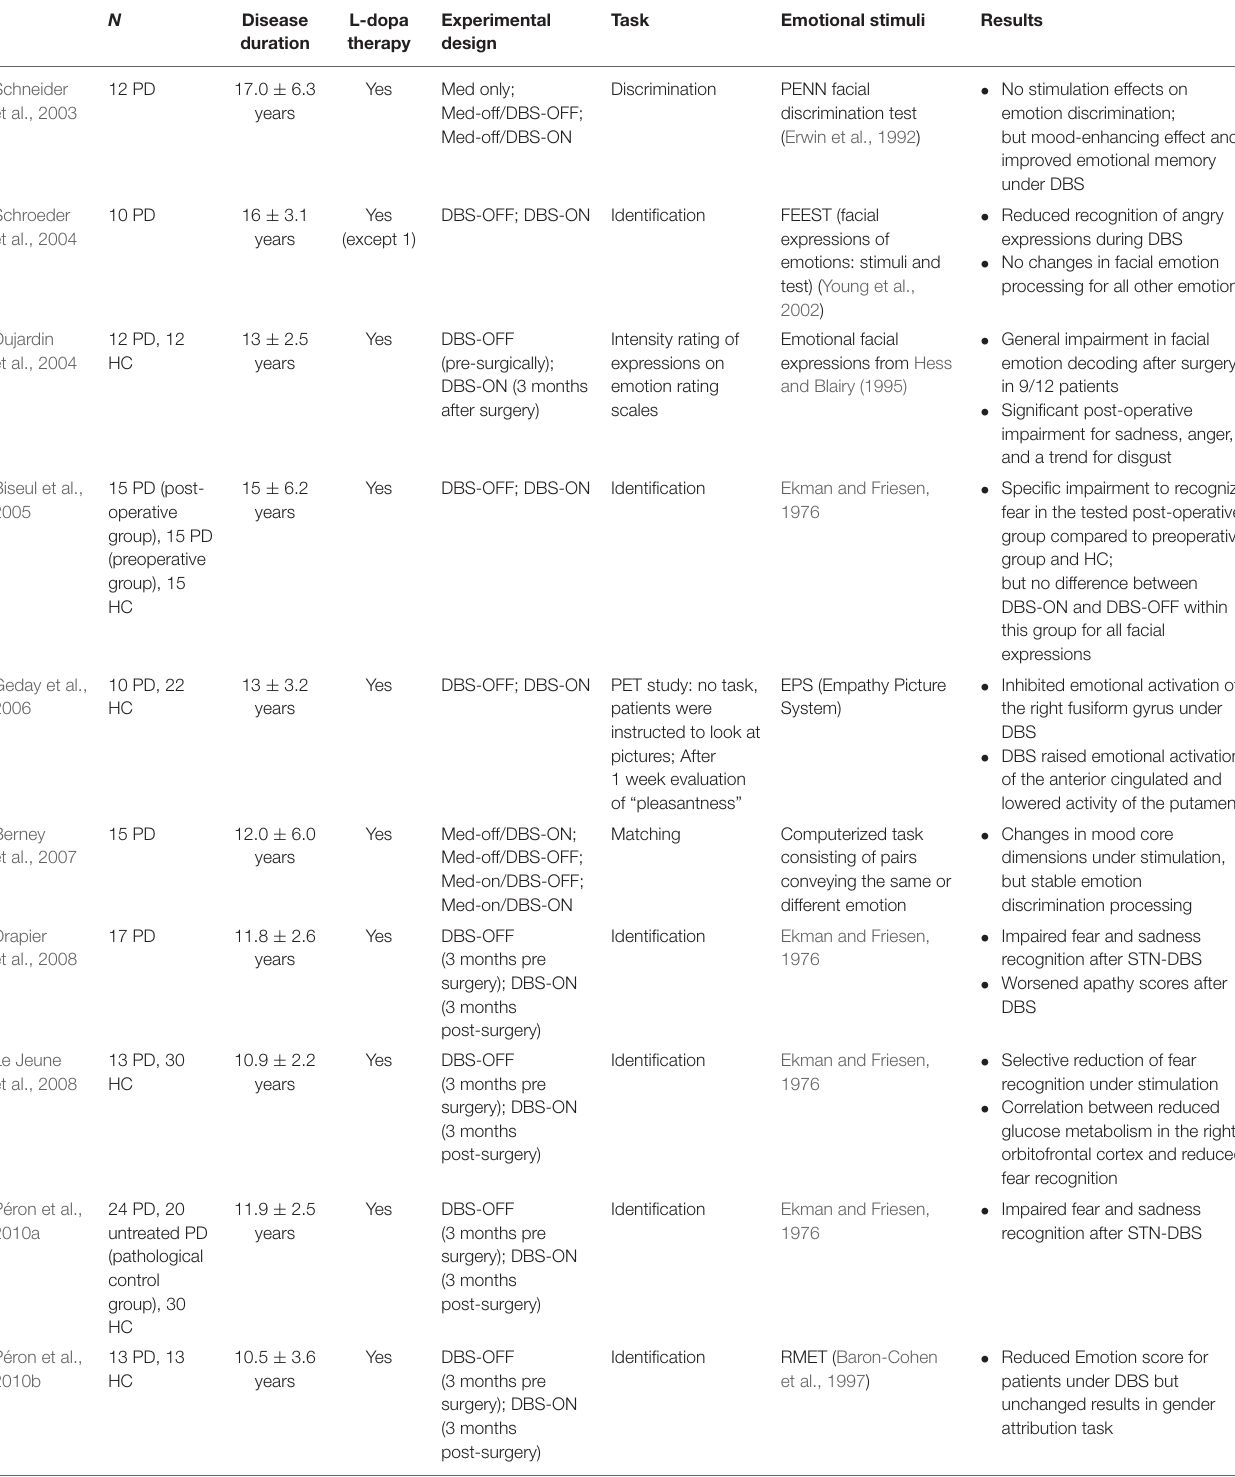
TABLE 1 | Influence of STN-DBS on recognition of emotional facial expressions in PD patients.